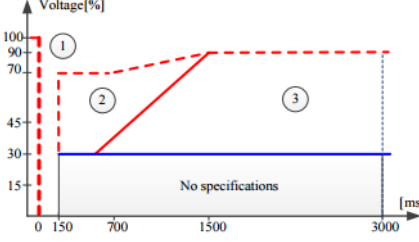
Figure 2. Requirement of FRT capability in Germany [32]. Table 3. FRT requirement for PVDG and its behavior during fault conditions [32].